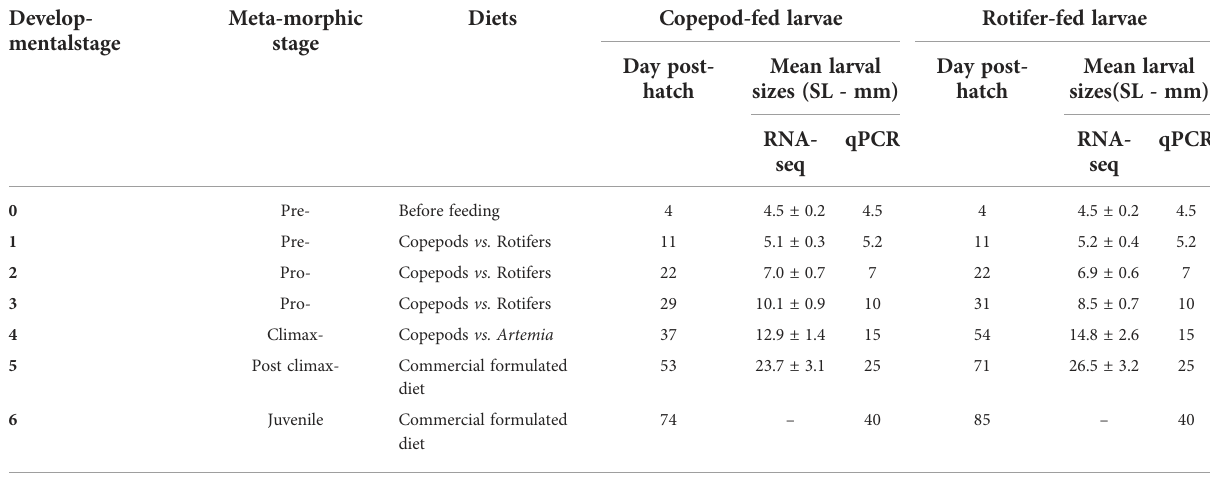
TABLE 2 Overview of larval developmental stages and mean sizes for RNA-seq and qRT-PCR at different sampling points. Develop- mentalstage